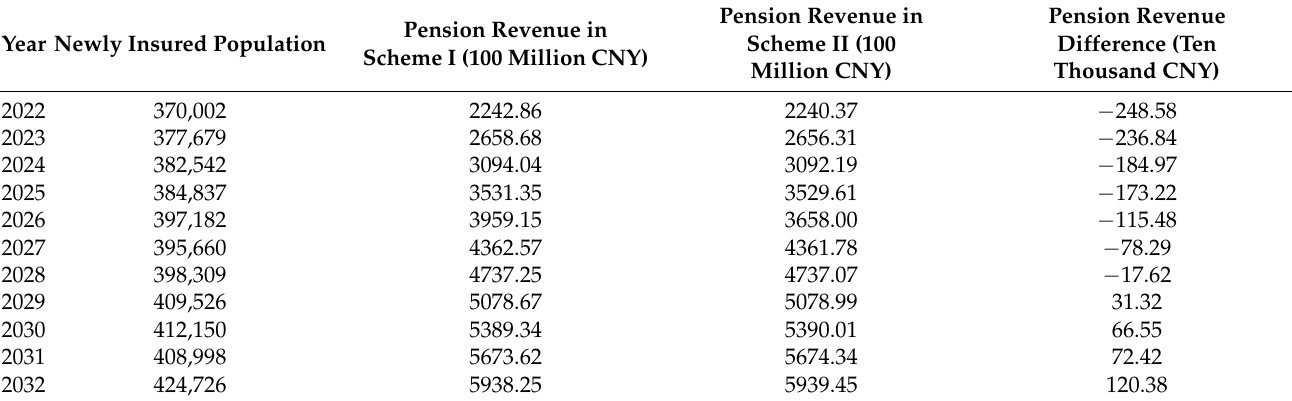
Table 12. Pension revenue in Anhui Province (deferred retirement plan